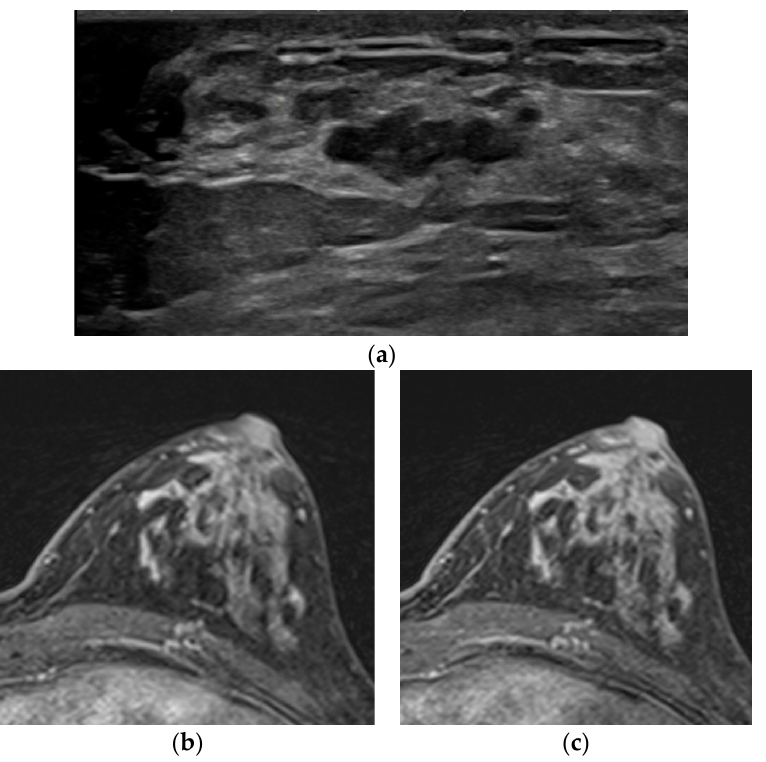
Figure 3. A 53-year-old woman with screening. ( a ) In the ultrasound, a 2 cm irregular hypoechoic mass was detected in the left breast in the 3-o’ clock direction and confirmed as invasive ductal carcinoma with ductal carcinoma in situ. The final pathology revealed 0.5 cm-sized invasive cancer with 2.4 cm-sized DCIS. No discernible lesion was identified in the subtraction image from the early phase ( b ) or the delayed phase of T1WI due to the marked level of BPE ( c ).